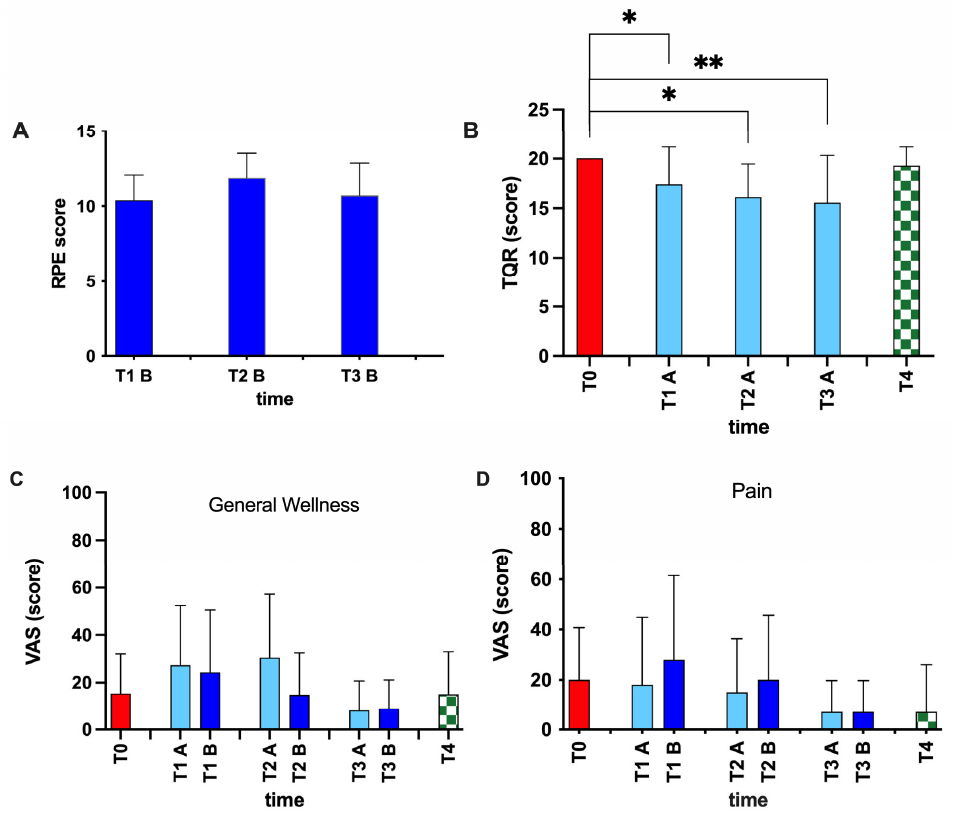
Figure 4. Borg and TQR scales and VAS score from all subjects. Borg scale ( A ) was assessed after every training session, while TQR scale ( B ) was assessed at the baseline (T0), before every training session, and after the season (T4). VAS scores for general wellness ( C ) and pain ( D ) were assessed at the baseline (T0), before ( A ) and after ( B ) every training session, and after the season (T4). Statistically significant difference comparisons are displayed as: * p < 0.05; ** p < 0.01.